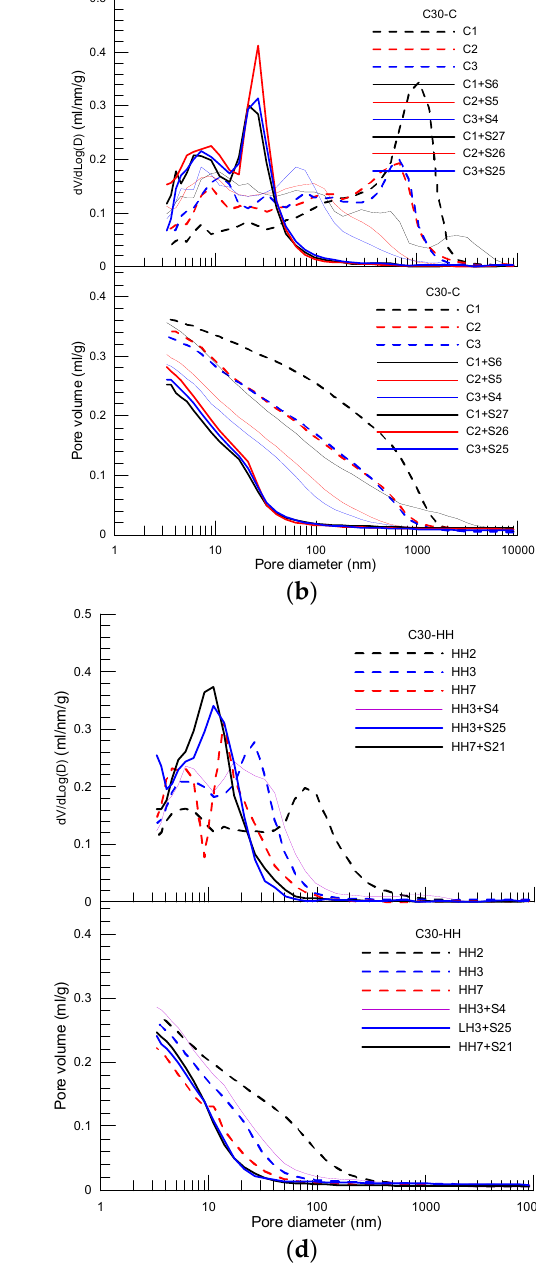
Figure 5. Cumulative (below) and derivative (above) pore volume versus pore diameter curves of the cement paste of C30 concrete subject to different curing procedures: ( a ) standard curing, ( b ) insulation cover curing, ( c ) heat curing with 40 °C and ( d ) heat curing with 60 °C.